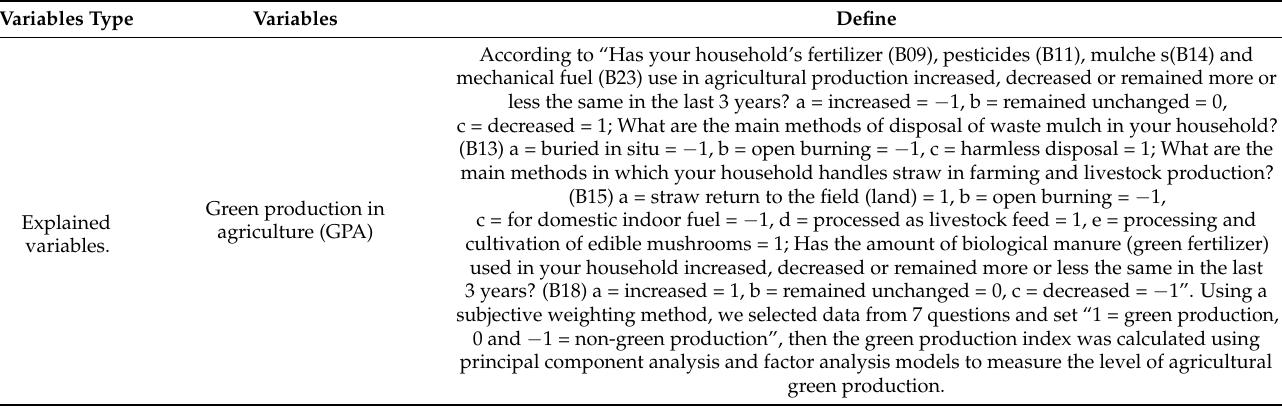
Table 1. Variable selection and